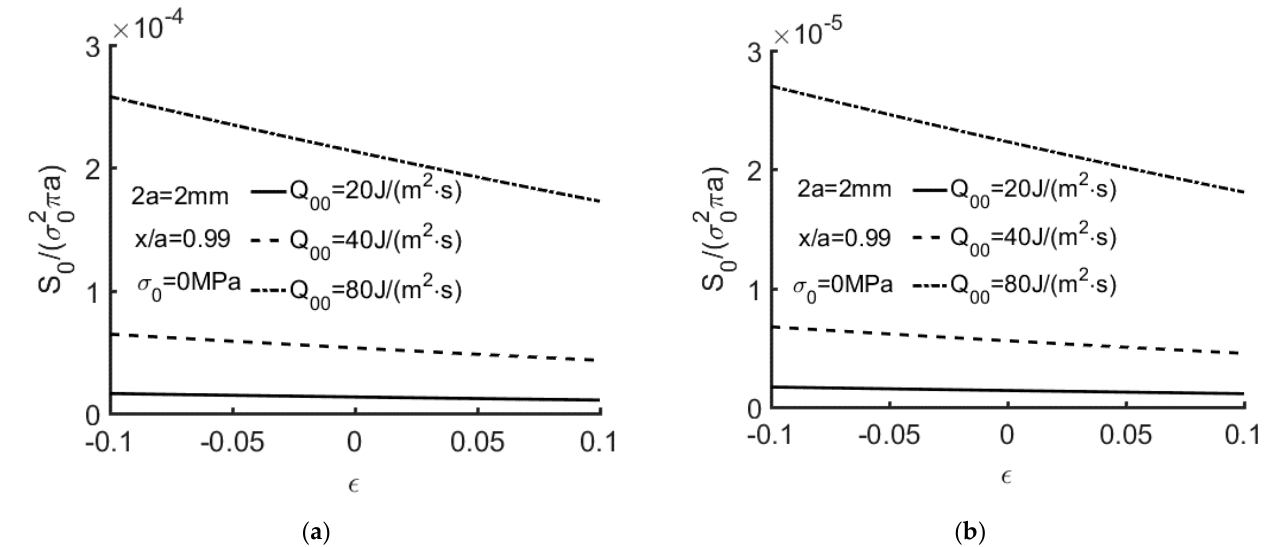
Figure 12. ( a ) S 0 /( σ 02 π a ) versus ε with Q 00 = 20, 40, 80 J/(m 2 · s) for E c = 1. (2 a = 2 mm, x/a = 0.99, σ 0 = 0 MPa). The orthotropic material listed in Table 1. ( b ) S 0 /( σ 02 π a ) versus ε with Q 00 = 20, 40, 80 J/(m 2 · s) for E c = 1. (2 a = 2 mm, x/a = 0.99, σ 0 = 0 MPa). The isotropic material listed in Table 2.